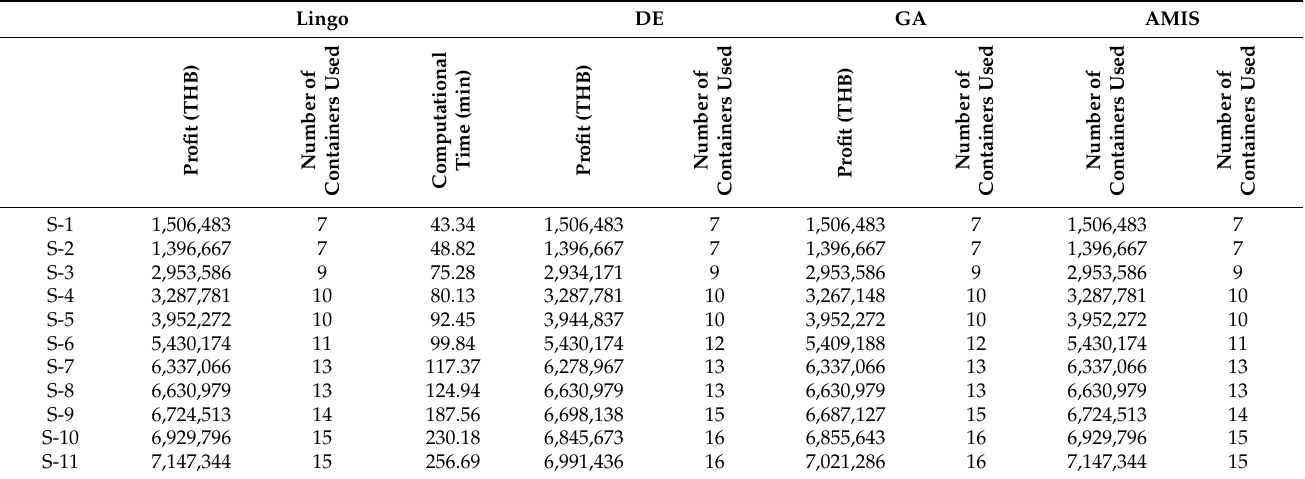
Table 12. Objective functions of small test instances.